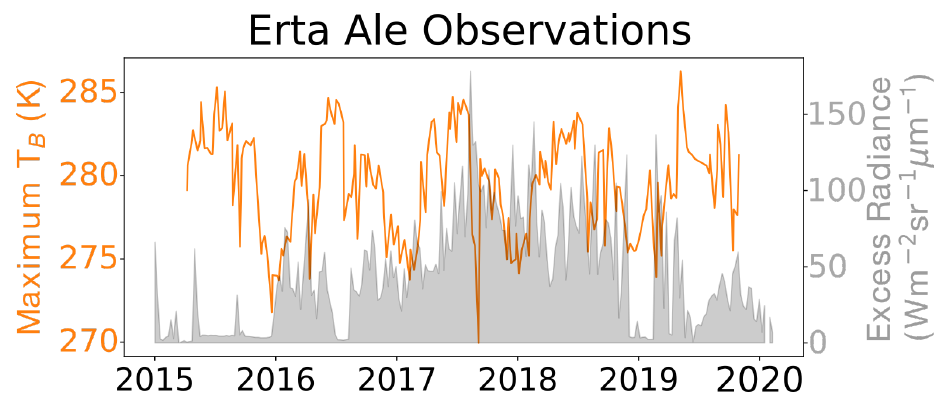
Figure 1. Maximum brightness temperatures observed by Soil Moisture Active Passive (SMAP) (orange) compared to infrared observations by MODIS (gray) [17] for the Erta Ale region. SMAP data are the 35 gridded elements over Erta Ale. Peaks in excess radiance observed by MODIS over the same area do not correlate with anomalously high brightness temperatures (Pearson correlation coefficient =